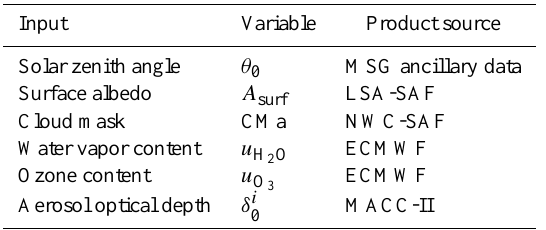
Table 3. Inputs used by SIRAMix to generate DSSF in an opera- tional framework.